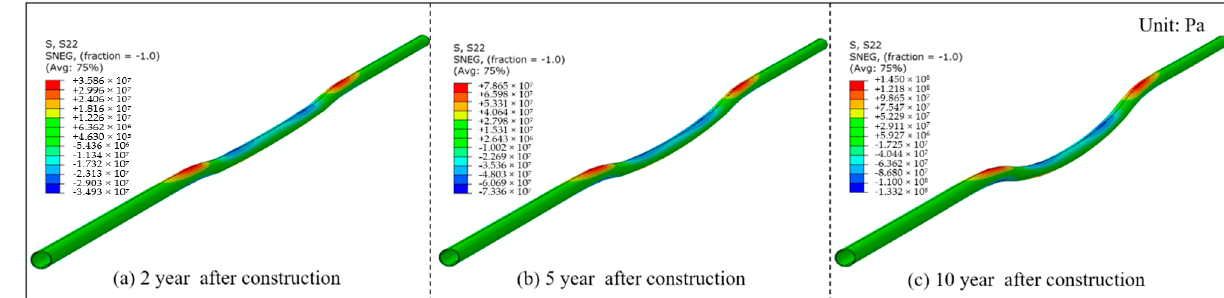
Figure 9. Vertical stress distribution of the buried pipeline in the 2nd ( a ), 5th ( b ), and 10th ( c ) years.